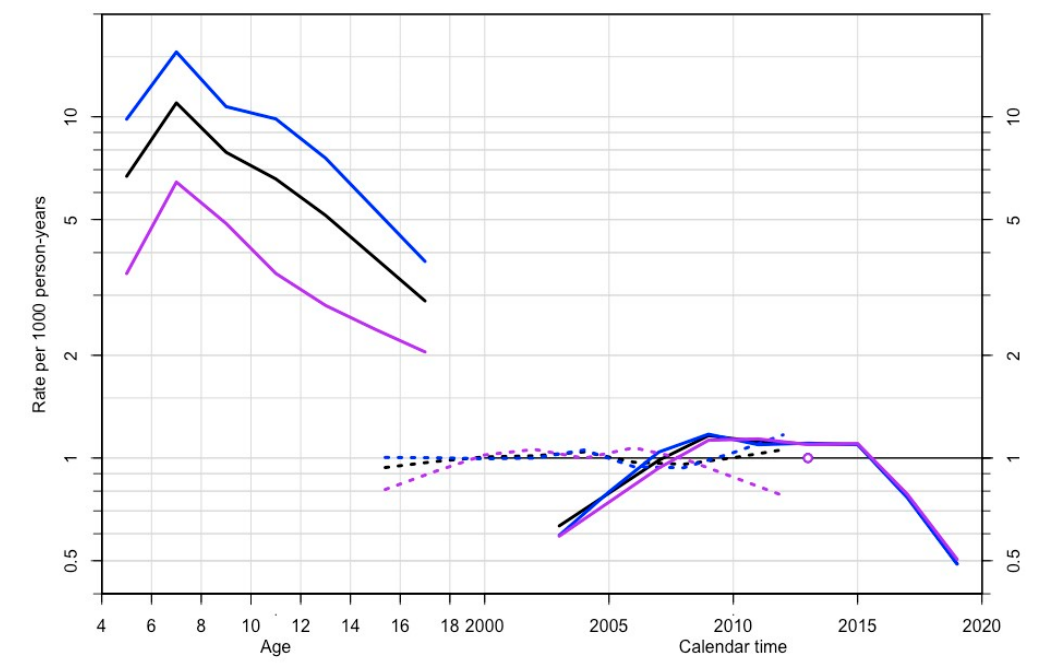
Figure 2. Age-period-cohort model. On the left, age-effect in rate scale; on the right, cohort (broken lines) and period (full lines) effect in risk ratio scale. Male (blue line), female (purple), both (black).